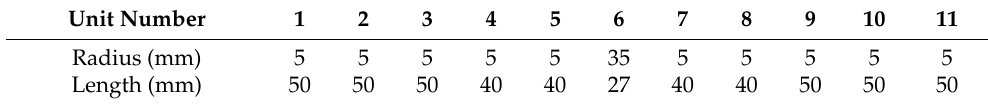
Figure 1. The mathematical model of the cracked rotor system. The rotor shaft contains 11 shaft units, each of which has 2 nodes. The specific parameters of the units are listed in Table 1. Table 1. Specific parameters of each